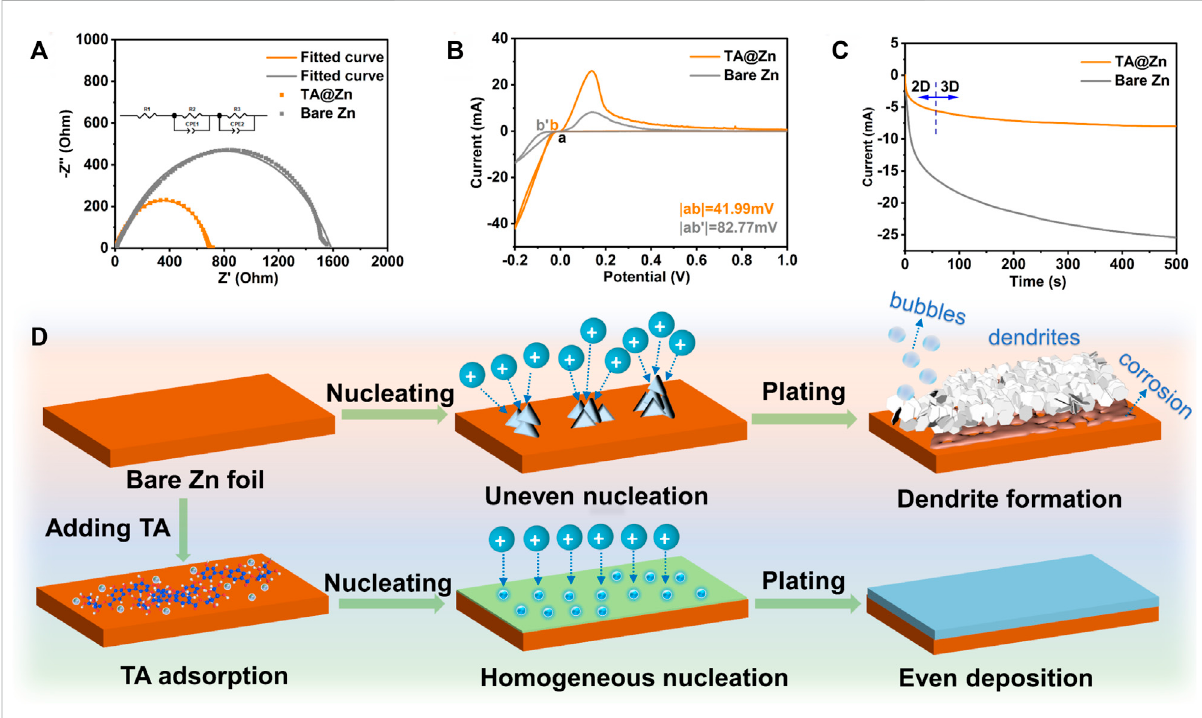
FIGURE 3 Zn plating behavior of bare Zn and TA@Zn. (A) electrochemical impedance spectra (EIS) of the Zn symmetric cells before cycled. (B) CV curves of the bare Zn|Ti and TA@Zn|Ti half cells. (C) chronoamperometric curves of symmetric cells using bare Zn and TA@Zn. (D) schematic illustration of Zn plating behavior on bare Zn and